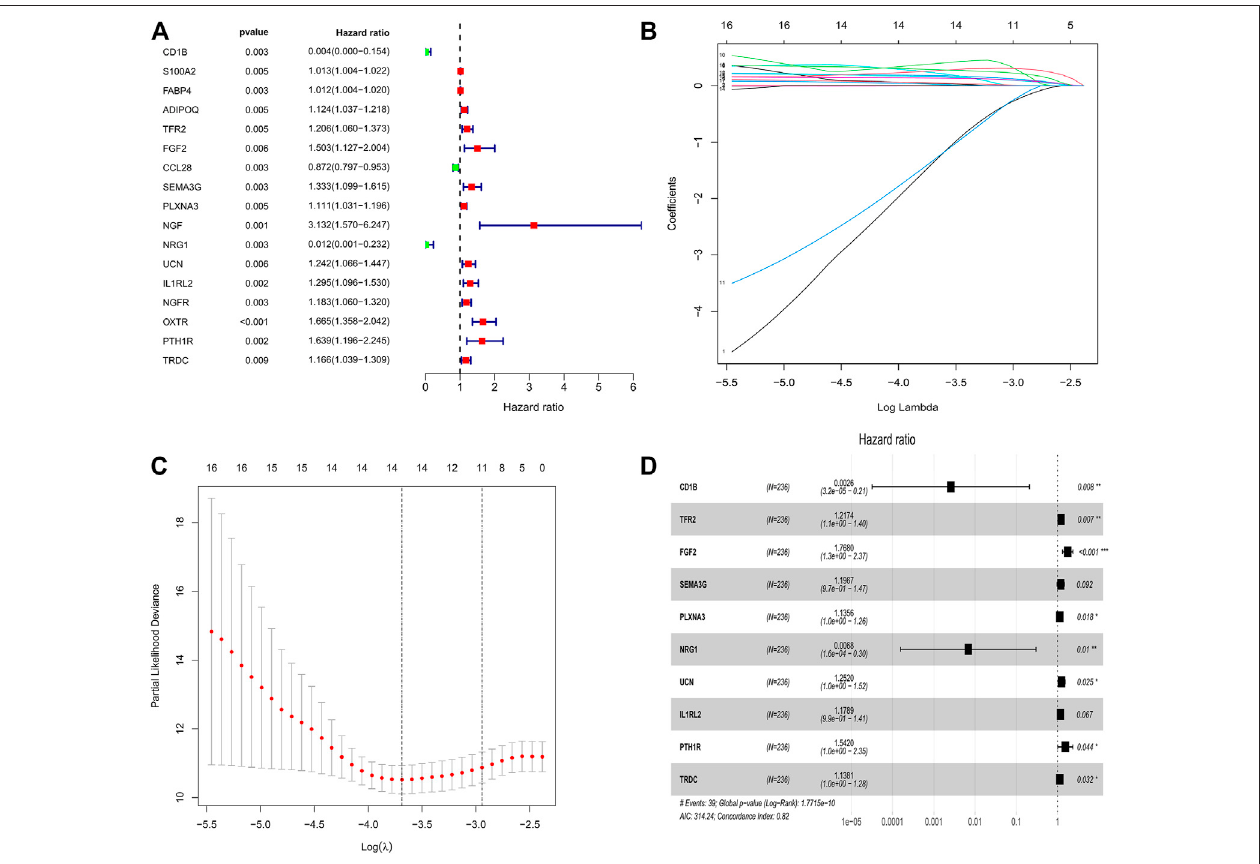
FIGURE 2 | Identi fi cation of survival related IRGs in patients with CRC. (A) Univariate Cox regression models identi fi ed 17 IRGs associated with prognosis of CRC patients. (B,C) Lassoregressionmodelsidenti fi ed14IRGs. (D) TenIRGswereidenti fi edtoconstructanovelprognosticsignaturebasedonmultivariateCoxregression models.